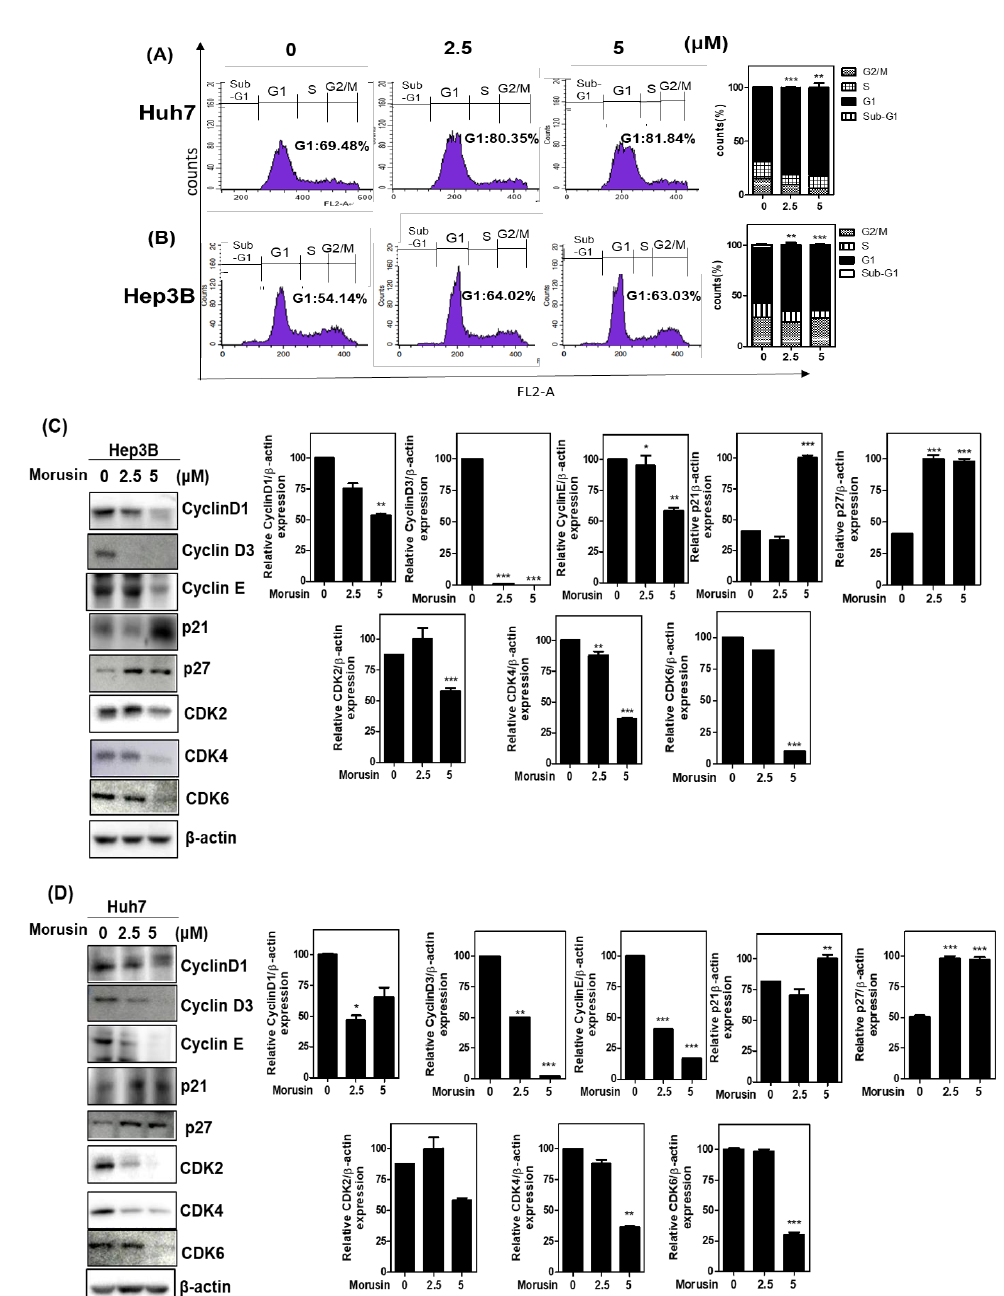
Figure 2. Effect of Morusin on G1 arrest and its related proteins in Huh7 and Hep3B cells. ( A ) Effect of Morusin on G1 arrest in Hep3B cells. *, p < 0.05, ***, p < 0.001 vs. untreated control. ( B ) Effect of Morusin on G1 arrest in Huh7 cells. Huh7 and Hep3B cells exposed to Morusin (2.5, 5 µ M) for 24 h were incubated with RNase A (10 mg/mL) for 1 h at 37 ◦ C and stained with propidium iodide (50 µ g/mL) for 30 min at room temperature in the dark. The stained cells were analyzed for DNA content by FACSCalibur. **, p <0.01, ***, p <0.001 vs. untreated control ( C ) Effect of Morusin on G1 related proteins in Hep3B cells *, p < 0.05, **, p < 0.01, ***, p < 0.001 vs. untreated control. ( D ) Effect of Morusin on G1 related proteins in Huh7 cells. Huh7 and Hep3B cells were treated with Morusin (2.5, 5 µ M) for 24 h. Cell extracts were prepared and subjected to Western blotting with Cyclin D1, Cyclin D3, Cyclin E, p21, p27, CDK2, CDK4, and CDK6 antibodies. β -actin was used as an internal control. Data represent means ± SD. *, p < 0.05, **, p < 0.01, ***, p < 0.001 vs. untreated control ( n =